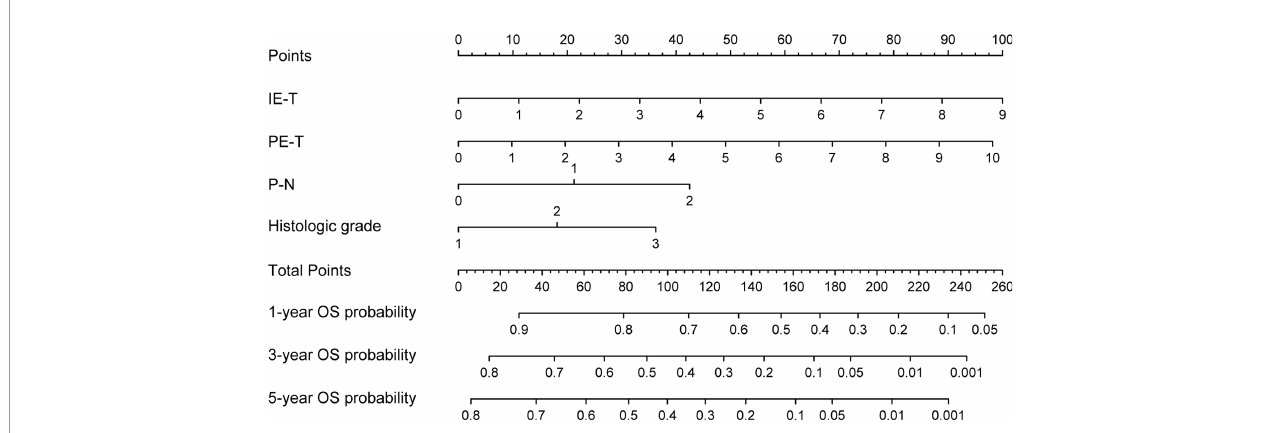
FIGURE 3 | Nomogram based on the clinical-pathological model for the prediction of 1-, 3- and 5-year OS. PE-T, physical examination-tumor size; IE-T, imaging examination-tumor size; P-N, pathological nodal involvement stage; OS, overall survival.